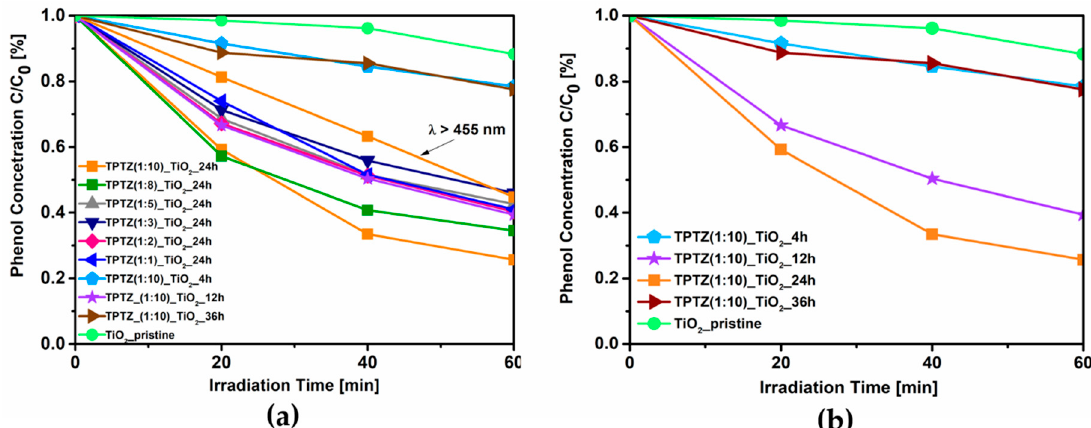
Figure 2. Efficiency of phenol degradation under visible irradiation ( λ > 420 nm or λ > 455 nm) in the presence of the TPTZ_TiO 2 samples prepared in various IL:TBOT molar ratios ( a ) and in different time periods ( b ).